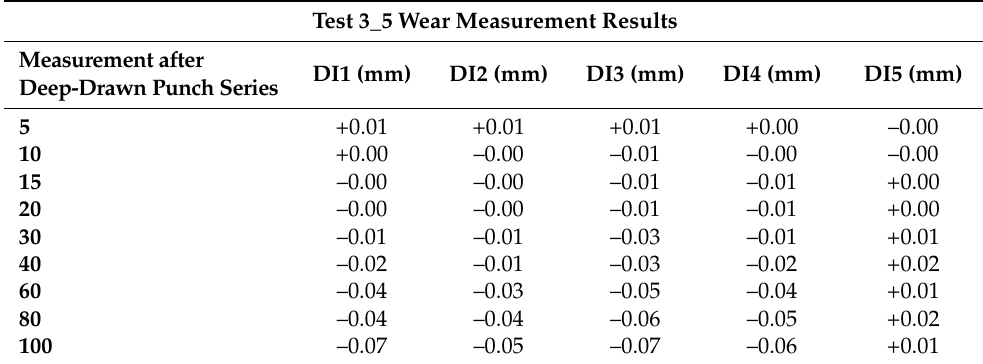
Figure 10. Wear of punch in Test 3_5 between 5 ( left ) and 100 pieces ( right ). All values are in mm unit. Table 14. Wear of punch in Test 3_5 between 5 and 100 pieces, measured values at given points.